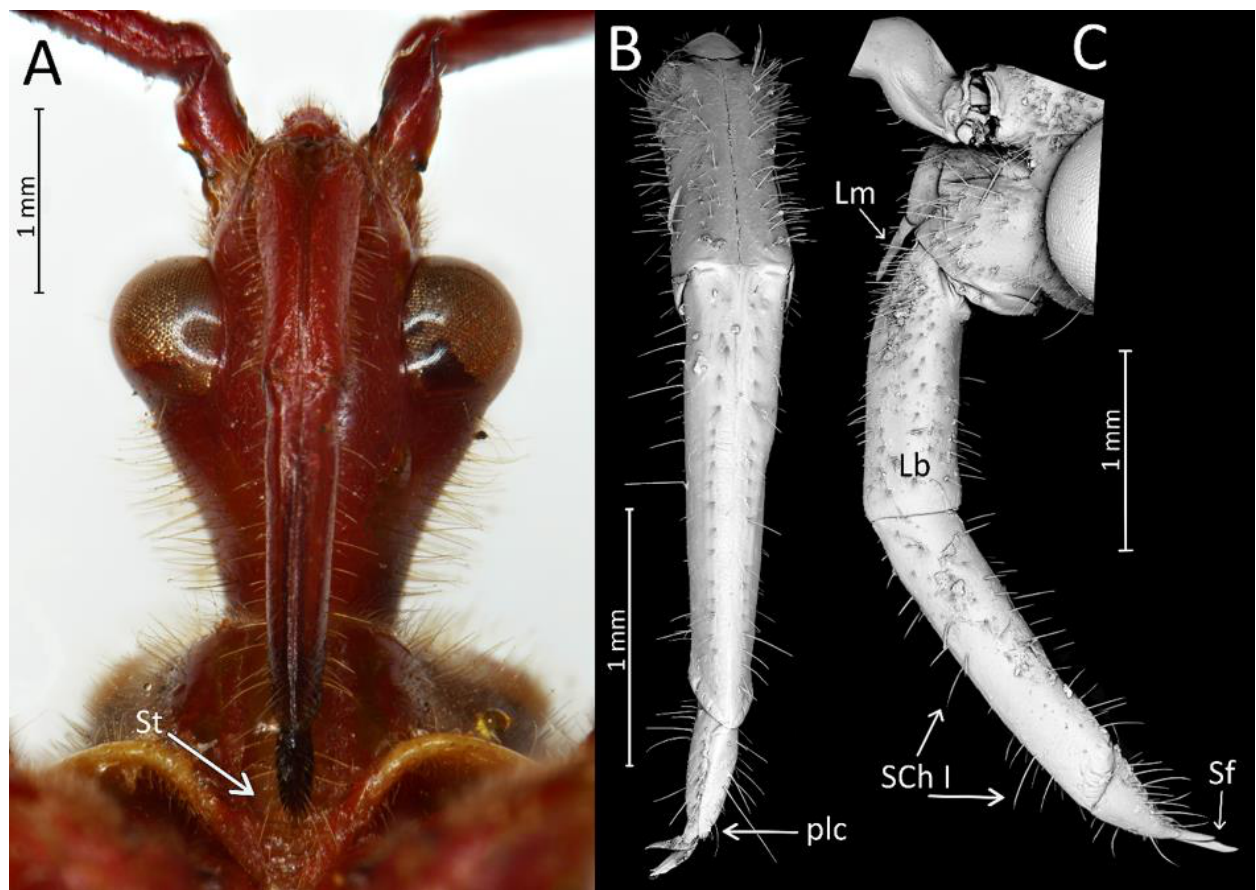
Figure 11. Head: ( A ) of Phonoctonus lutescens (Guérin-Méneville & Percheron, 1834), ventral view; ( B ) of P. fasciatus (Beauvois, 1805), ventral view; ( C ) of P. fasciatus (Beauvois, 1805), lateral view. Lb — labium; Lm — labrum; plc — plectrum; SCh I — sensillum chaeticum type I; Sf — stylet fascicle; St — stridulitrum.